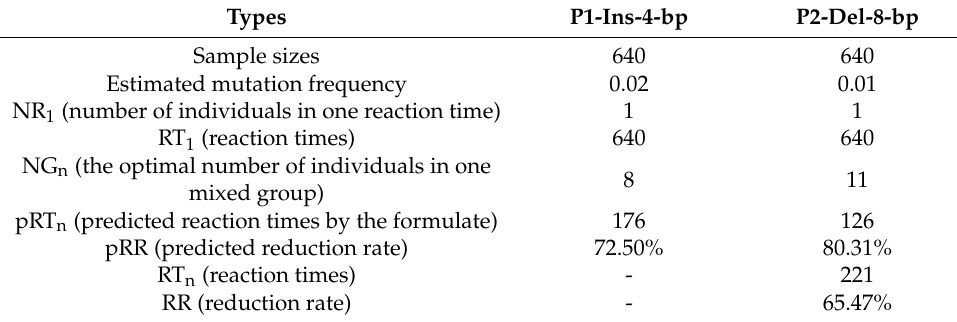
Table 5. The reaction times of different loci in the SDBCGR population.